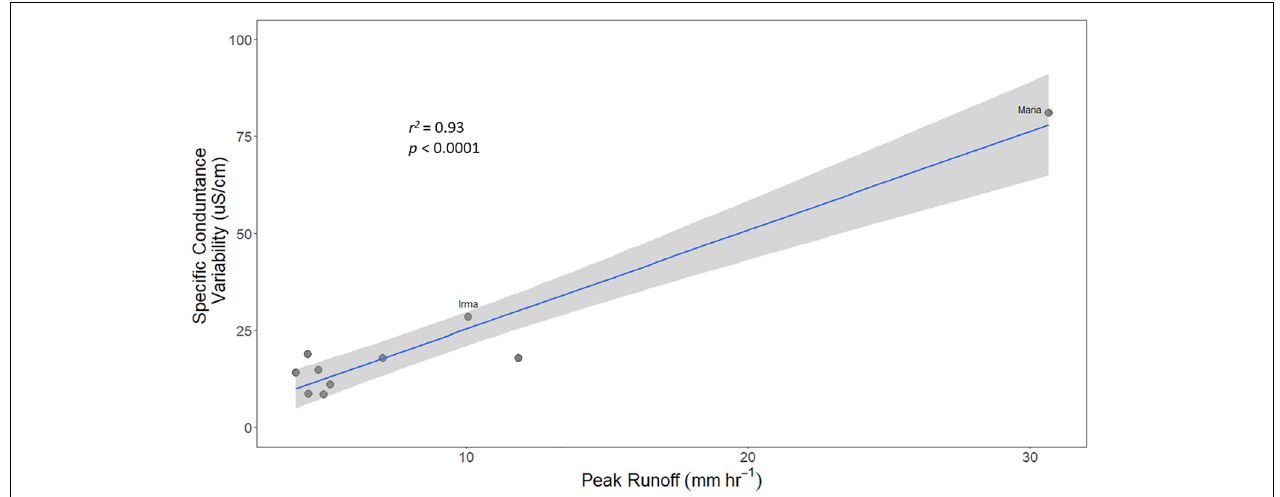
FIGURE 7 | Linear regression of intra-storm variability in specific conductance (highest value-lowest value) and peak storm runoff at Quebrada Sonadora (QS). The points associated with Hurricane Irma and Hurricane Maria are